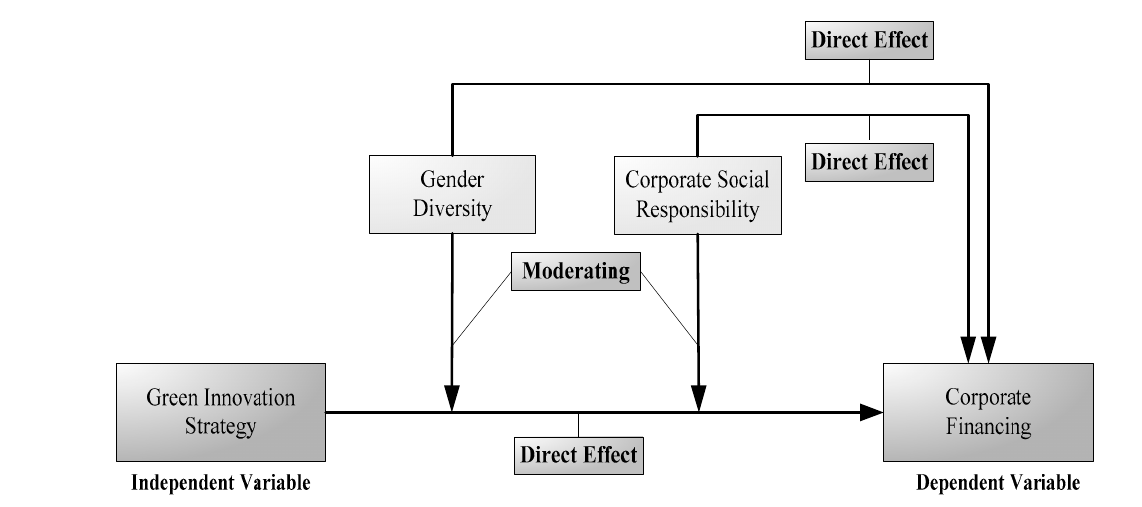
Figure 1. Conceptual